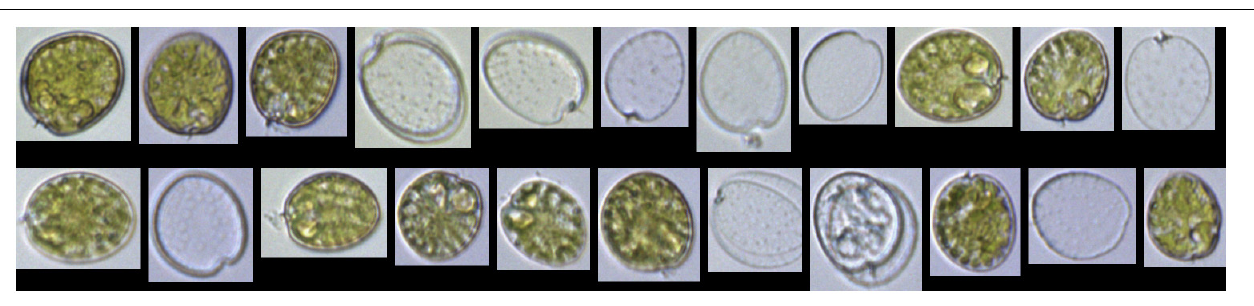
Frontiers in Marine Science |